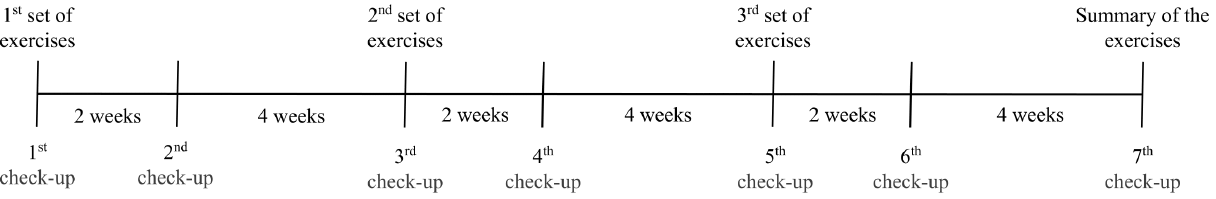
Figure 1. Timeline of the rehabilitation